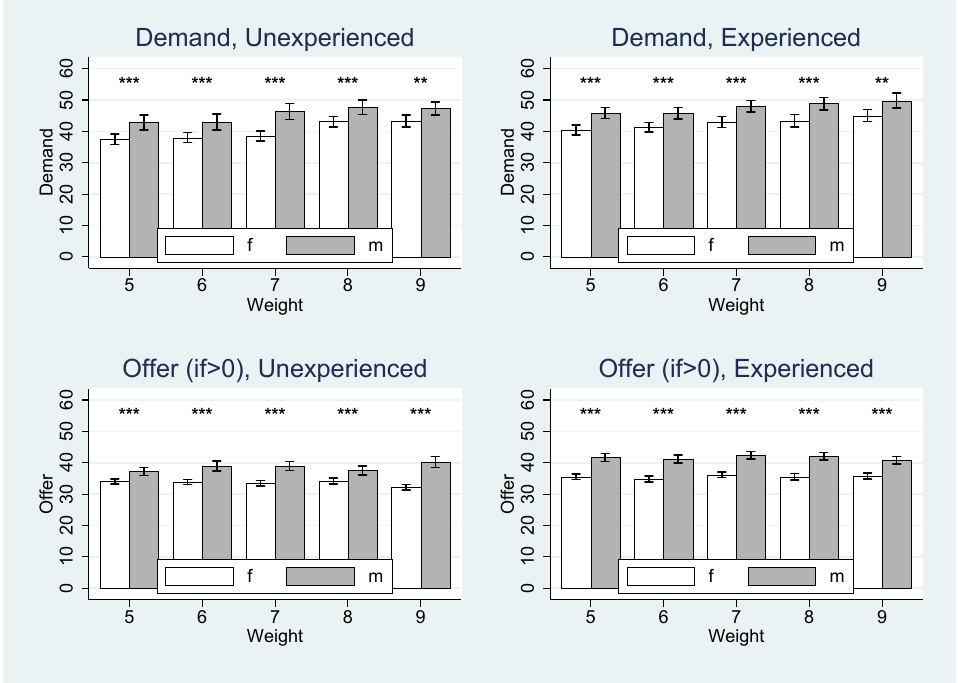
Figure A2. Proposer’s Demand (upper panels) and Offer if > 0 (lower panels) in P IT by Nominal Voting Weight and Gender. Significance levels: * p ≤ 0.10, ** p ≤ 0.05, *** p ≤ 0.01. Error bars represent 90% confidence